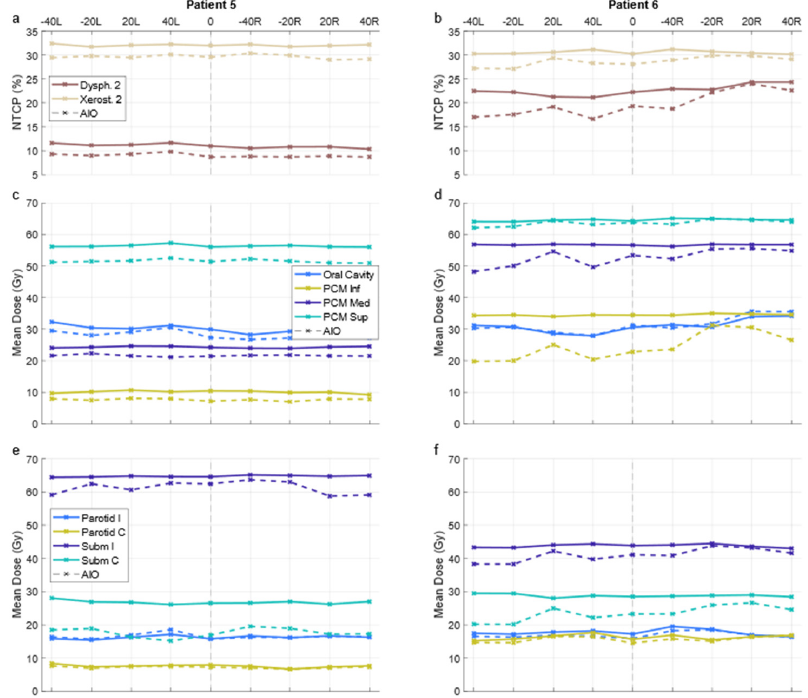
Figure 4. NTCPs ( a , b ) and OAR mean doses ( c – f ) over all plans for two patients. Solid and dashed lines indicate KBP and AIO plans, respectively. X-axis indicates the angular deflection of one of the fields; “0” corresponds to the default arrangement and “ − 40R” to the plan where the right field (in patient coordinates) is deflected by − 40 degrees. PCM Inf/Med/Sup = inferior/middle/superior phar ‐ yngeal constrictor muscle; Parotid I/C = ipsi ‐ /contralateral parotid gland; Subm I/C = ipsi ‐ /contrala ‐ teral submandibular gland; KBP = knowledge ‐ based plan; AIO = automatic iterative optimizer ‐ gen ‐ erated plan.